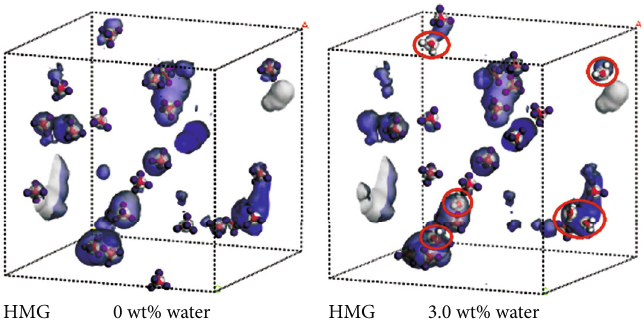
Figure 6: Simulation of adsorption of CH competitive adsorption